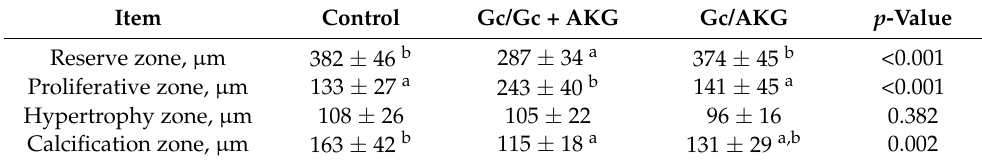
Table 8. The structure of the femoral growth plate cartilage in 35-day-old piglets.